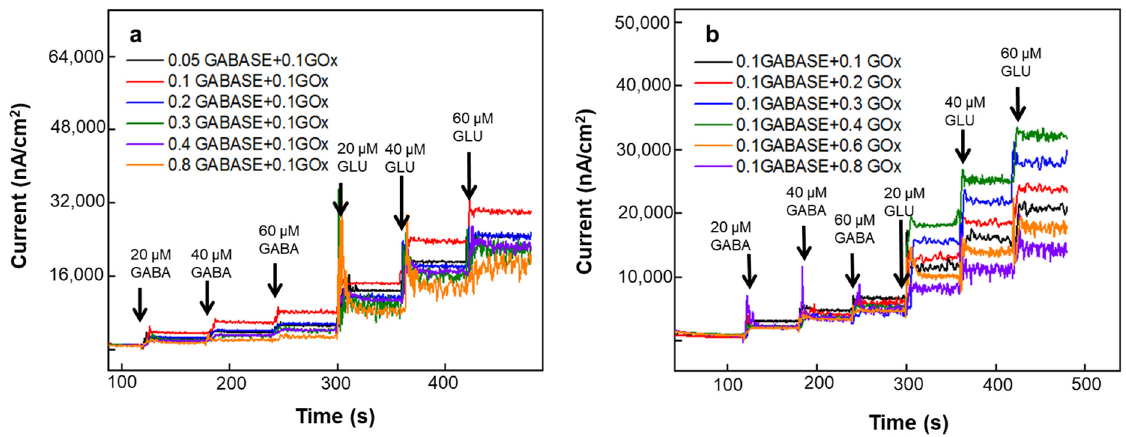
Figure 4. In vitro calibration of GABA microbiosensors at ( a ) different GABASE concentrations (0.05 to 0.8 U/ μ L) and a fixed GOx concentration (0.1 U/ μ L) and ( b ) at different GOx concentrations (0.1 to 0.8 U/ μ L) and a fixed GABASE concentration (0.1 U/ μ L). The experiments were carried out in 100 μ M α -ketoglutarate +1X PBS. The microbiosensors were biased at +0.7 V vs. Ag/AgCl reference. The solution was stirred at 200 rpm and maintained at 37 °C.